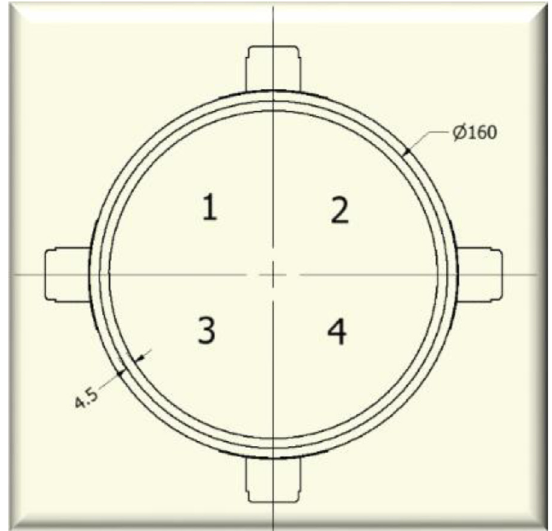
Fig. 9. Device designed to pull the Feeler PIG.